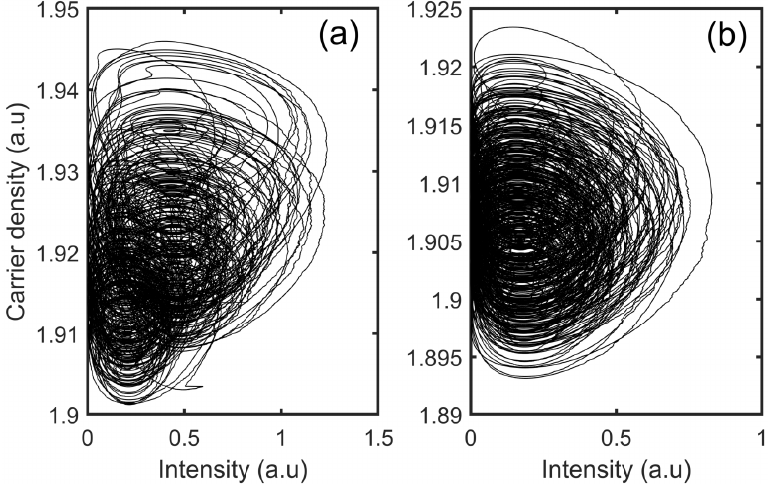
Figure 2. Chaotic attractors in the phase space of the laser’s intensity output and the carrier density. ( a ) Transmitter laser and ( b ) Receiver